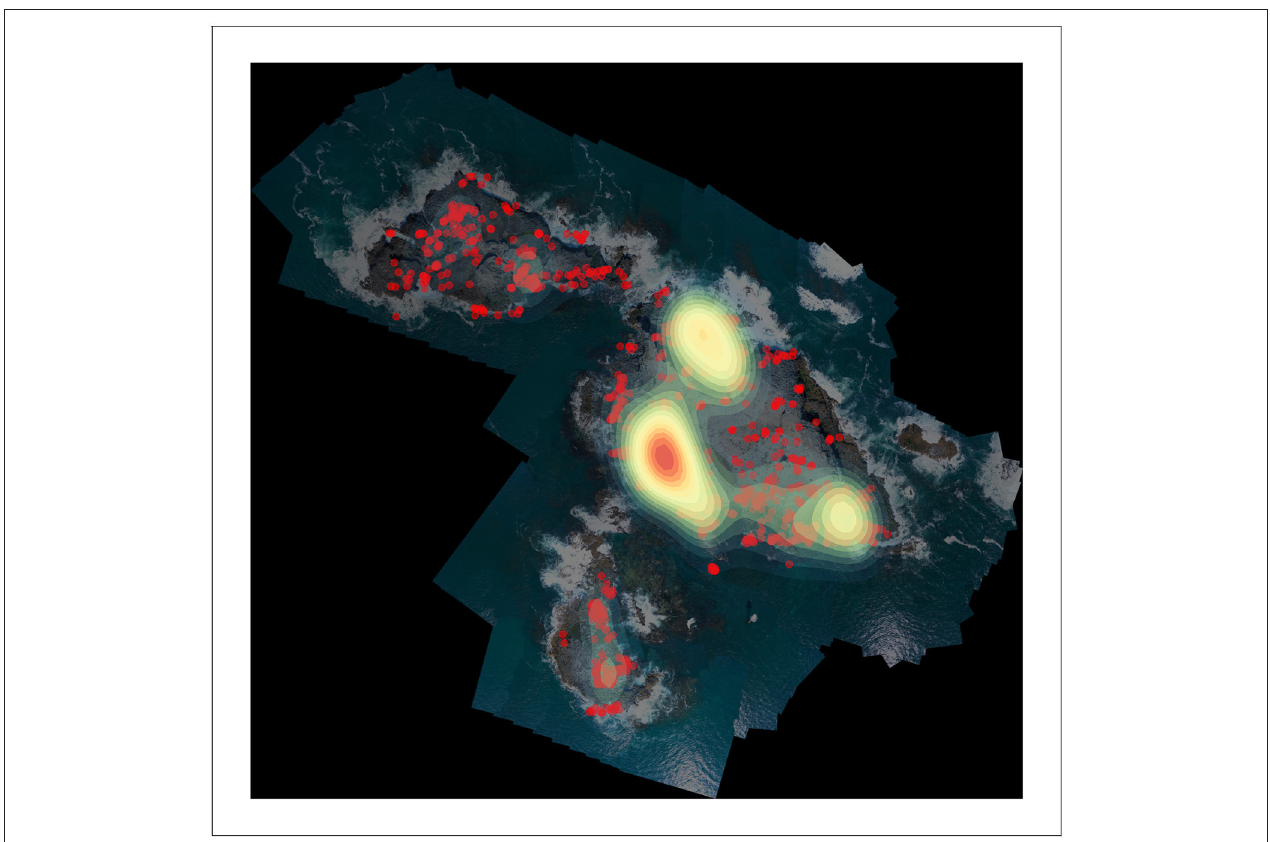
FIGURE 4 | Mapped x and y co-ordinate data (red dots) for Australian fur seal pups at Seal Rocks counted from Unpiloted Aerial Vehicle (RPA) images obtained on Survey 3, 12 October 2016. Overlayed heat map shows the density of aggregated pups from less dense (yellow) to more dense (red).